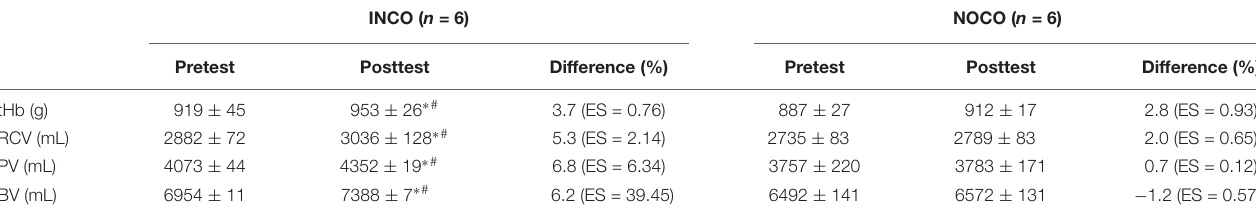
TABLE 2 | Total blood parameters before and after 4 weeks of